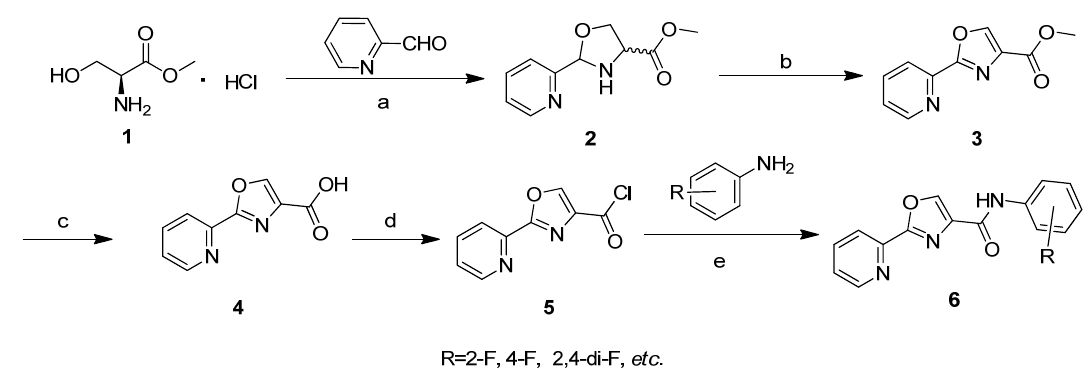
Table 1. Fungicidal activities (inhibition rate/%) on Botrytis cinereal of compounds 6 . Compd.